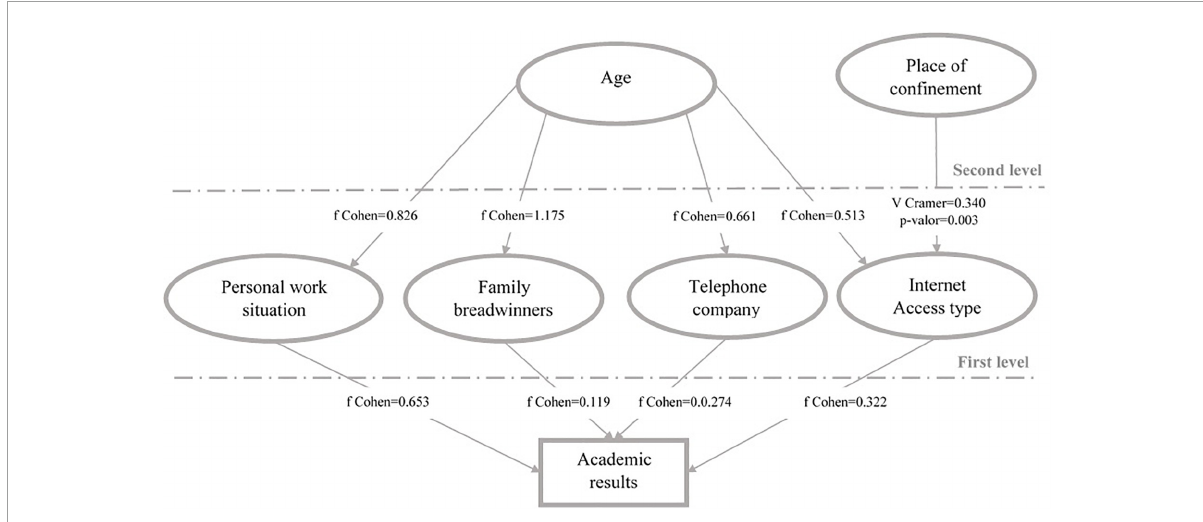
FIGURE3 Causal diagram showing the relationship between academic results and student-related variables during a state of alarm in which virtual teaching is carried out.